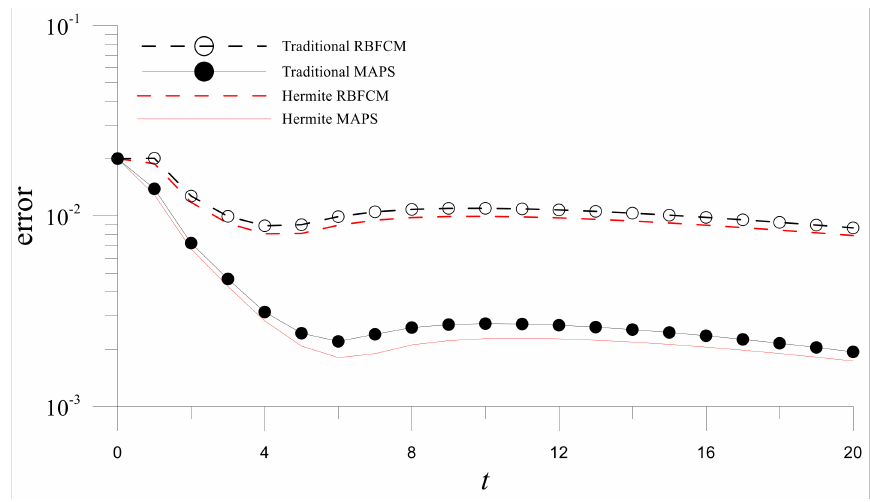
Figure 5. Time histograms of errors for numerical solutions obtained by the four methods in Example 1.